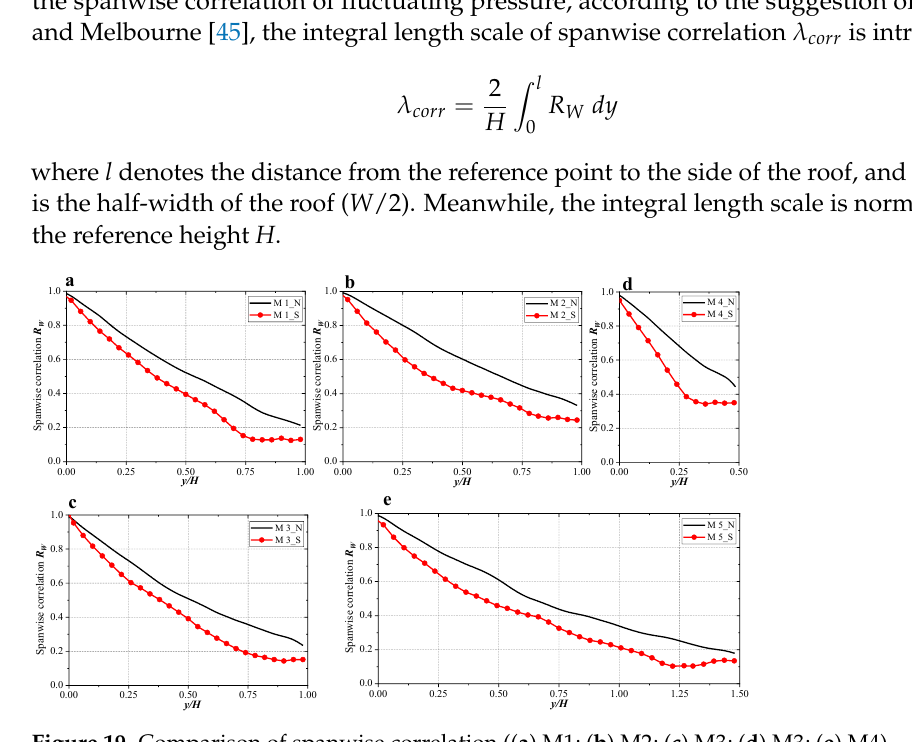
Figure 19. Comparison of spanwise correlation (( a ) M1; ( b ) M2; ( c ) M3; ( d ) M3; ( e ) M4).